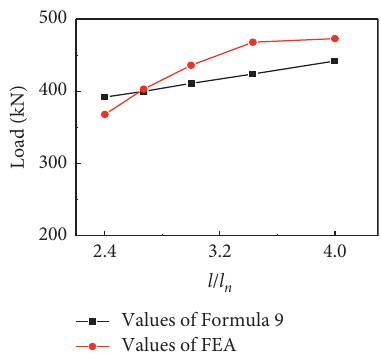
Figure 35: Values of formula (9) and FEA under changing of vertical height of shear key (models FE24 to